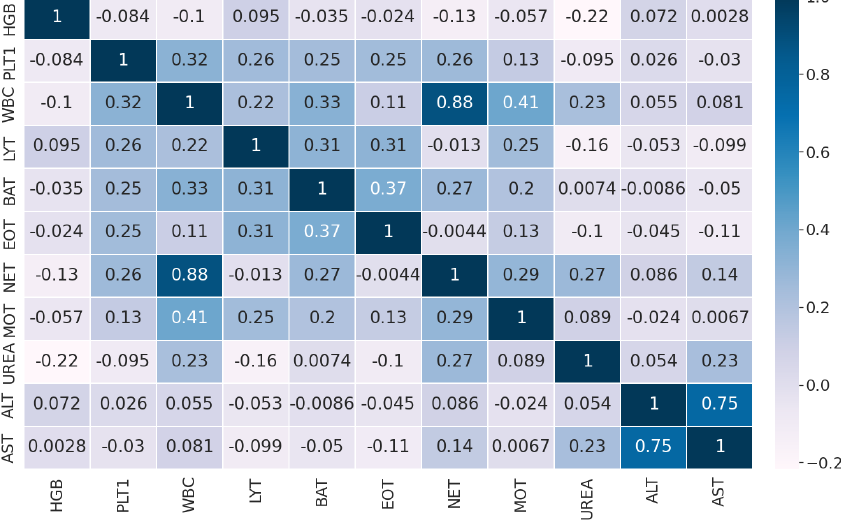
Figure 5. Pairwise Pearson correlation of the features in Dataset